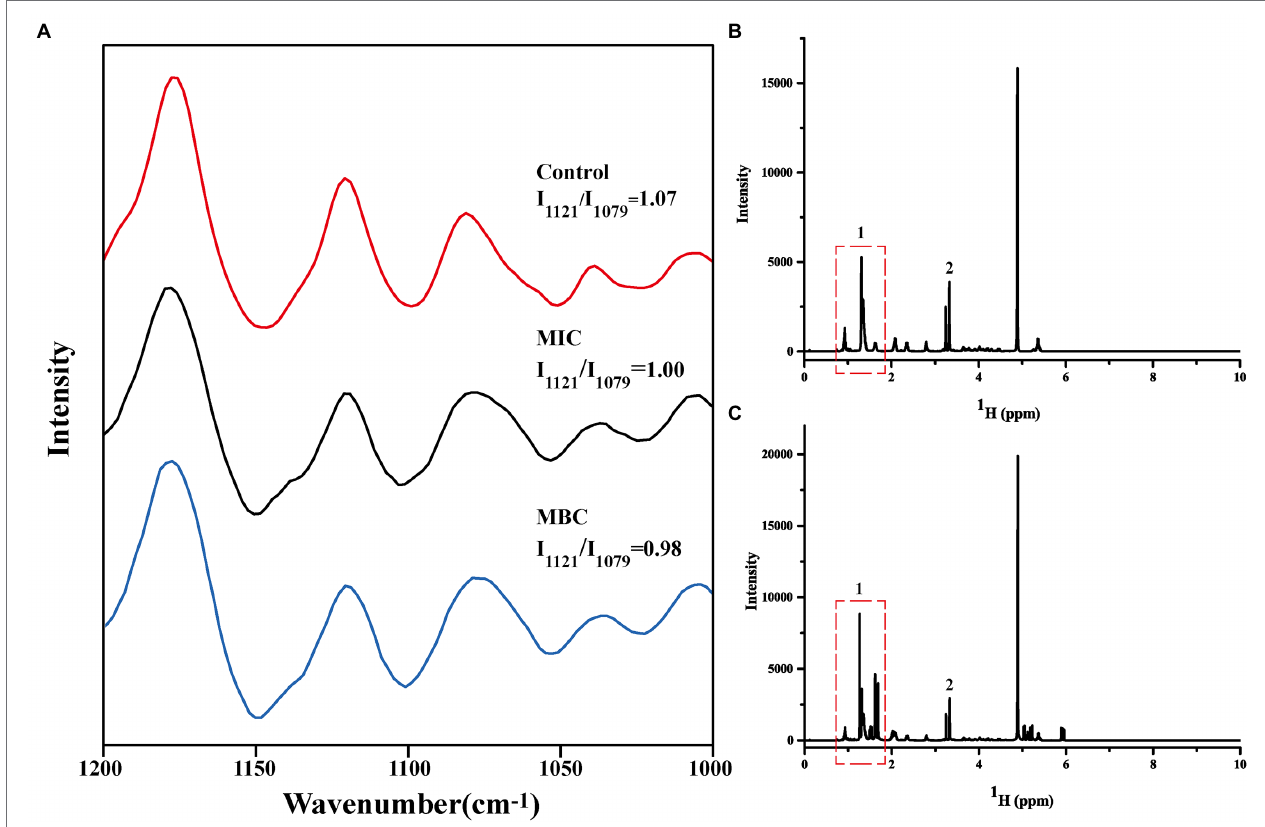
FIGURE 4 | Changes in Raman spectra of cell membrane phospholipids (A) ; One-dimensional 1 H NMR spectra of cell membrane phospholipids before (B) and after (C) reaction with